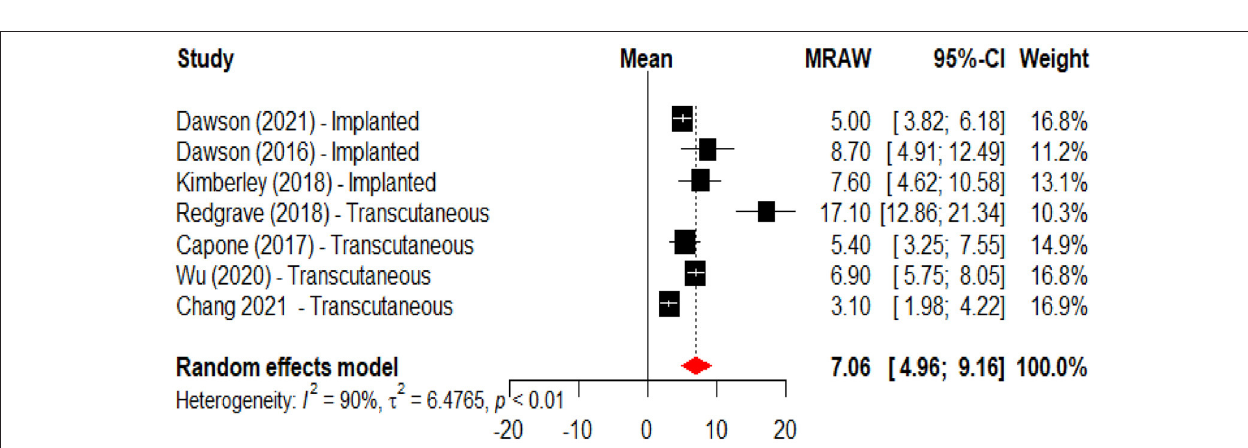
FIGURE 2 | Forest plot for the meta-analysis of vagus nerve stimulation effects on upper limb motor function (FMA-UE score increase) when compared to a control intervention. Dawson et al. ( 34), Dawson et al. (47), and Kimberley et al. (47) used implanted stimulation, Capone et al. (46), Wu et al. (43), and Chang et al. (44) used transcutaneous stimulation.